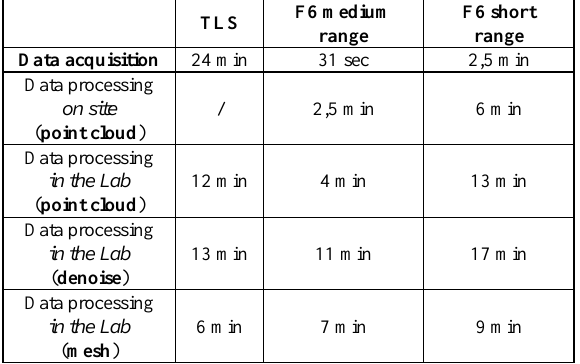
Table 3. Time comparison for obtaining the mesh of the decorative rosette through the Echo software of Mantis Vision.